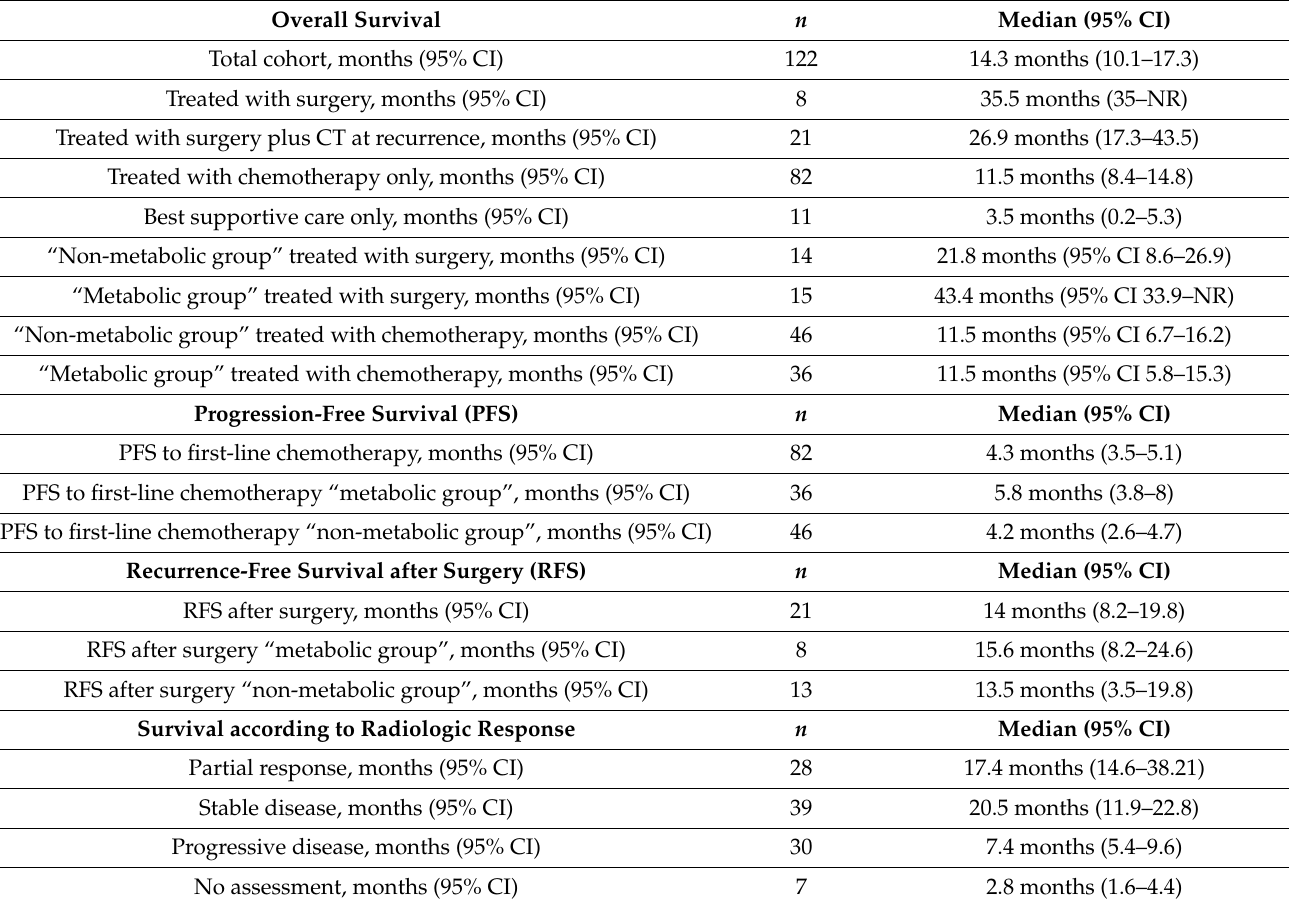
Table 3. Overall survival, progression-free survival and relapse-free survival in the total cohort and